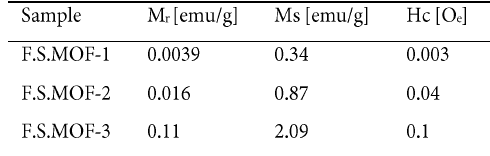
Table 4. Nitrogen gas adsorption analysis and specific surface area Table 5. Magnetic parameters of